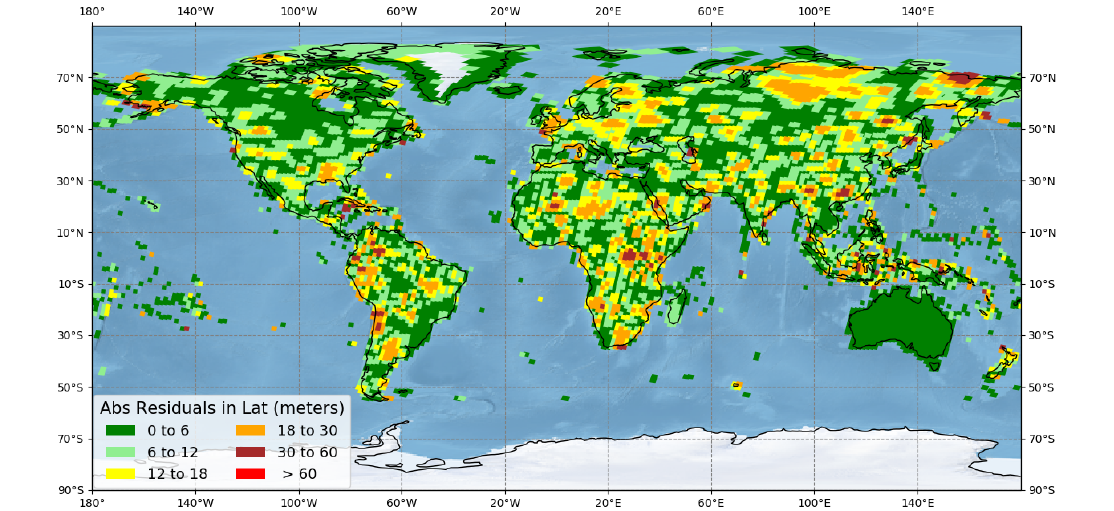
Figure 6. Mean residuals of the GCPs in the latitude direction for each of the WRS-2 paths/rows, computed from the block triangulation solution.